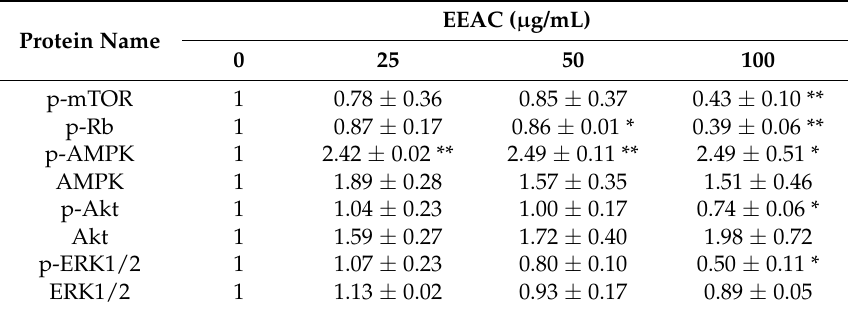
Table 1. Fold changes of detected proteins in A549 cells treated with EEAC.